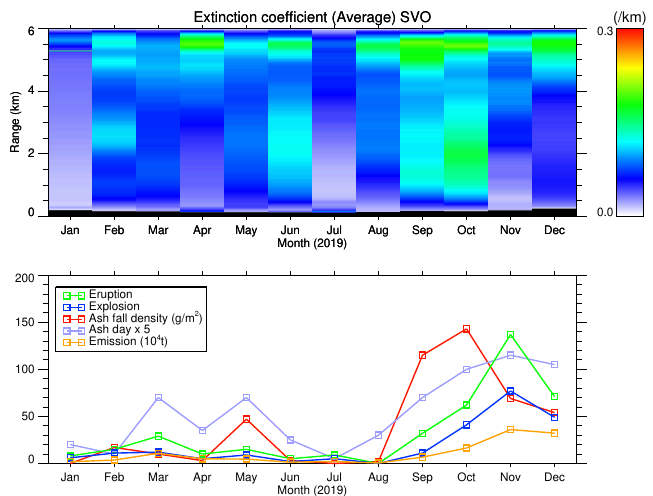
Figure 5. Time-range plot of aerosol extinction coefficients ( top , SVO lidar, 532 nm) and eruptive activity at Sakurajima in 2019 ( bottom , see Figure 3 for details). The number of ash fall days is rescaled by a factor of